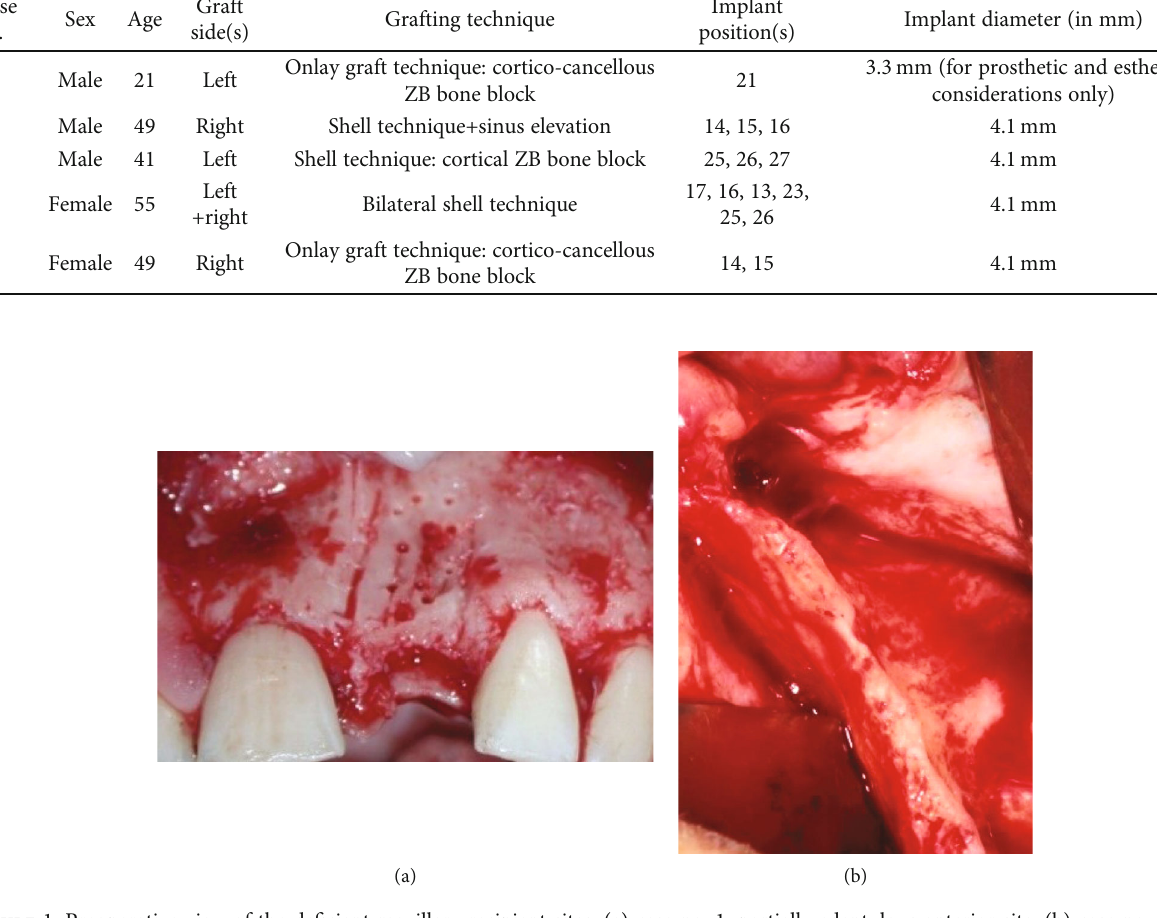
Figure 1: Preoperative view of the de fi cient maxillary recipient sites: (a) case no. 1: partially edentulous anterior site; (b) case no. 2: fully edentulous posterior